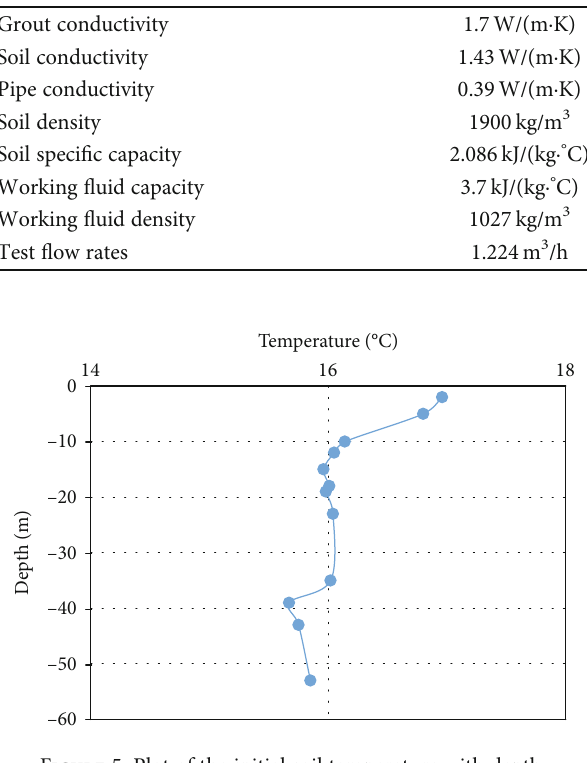
Figure 5: Plot of the initial soil temperature with